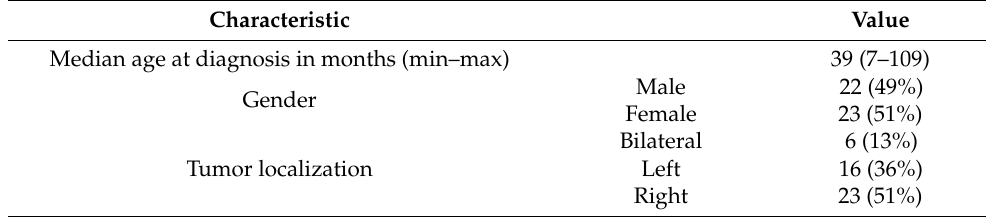
Table 2. Baseline characteristics ( n = 45). Numbers are count (percentage) unless otherwise specified.